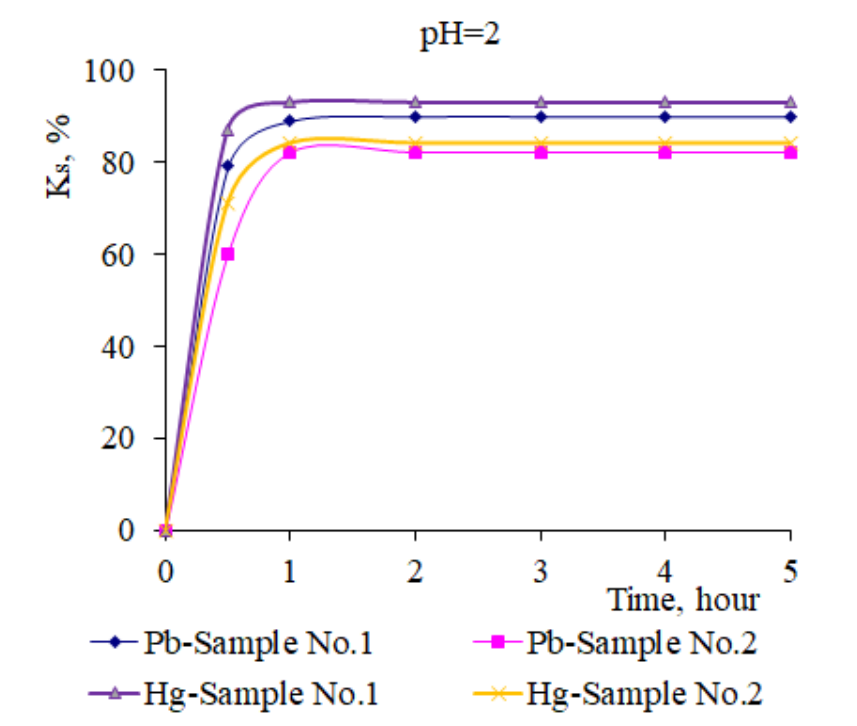
Fig. 2. Kinetics of sorption of lead ions and mercury by model samples of enterosorbents